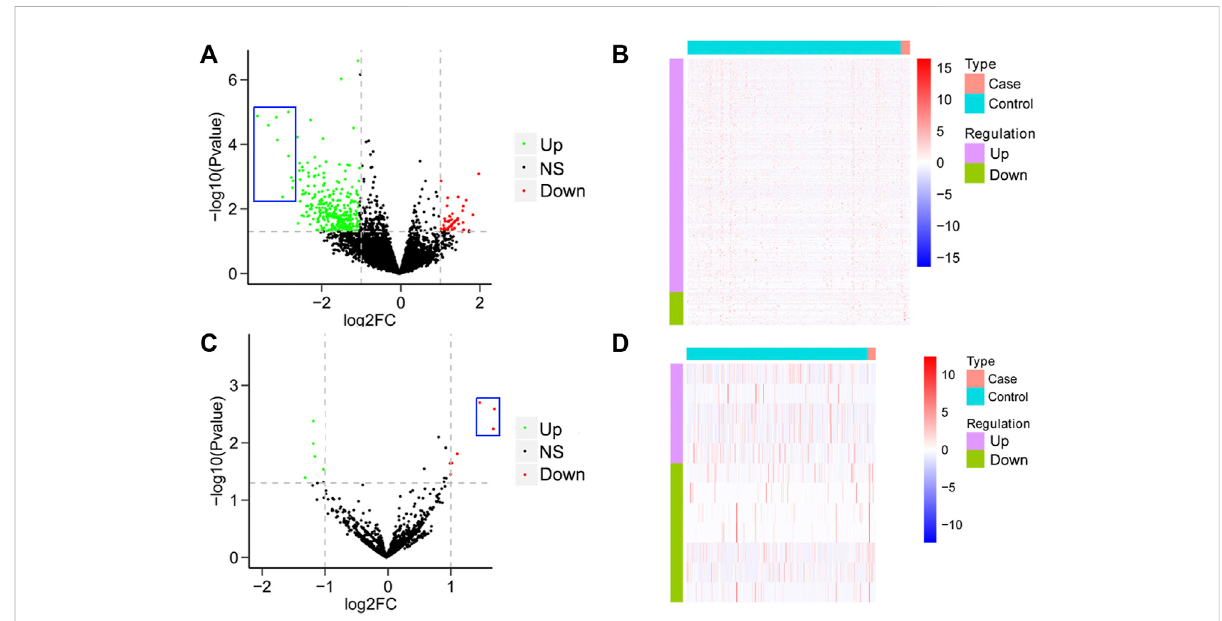
FIGURE 1 Analysis of differential mRNAs and miRNAs comparing pAML and control groups. (A) Volcano map of differentially expressed mRNAs between two groups. The horizontal axis represents the multiple differential expression (Log2FC), the vertical axis represents − log10 (FDR). The green dots indicate upregulated genes, and the red dots indicate downregulated genes, respectively. (B) Heat map of differentially expressed mRNAs. The horizontalaxisrepresents thesample, verticalaxisrepresentsdifferentgenes. (C) Volcano mapofdifferentiallyexpressed miRNAsbetween two groups. (D) Heat map of differentially expressed